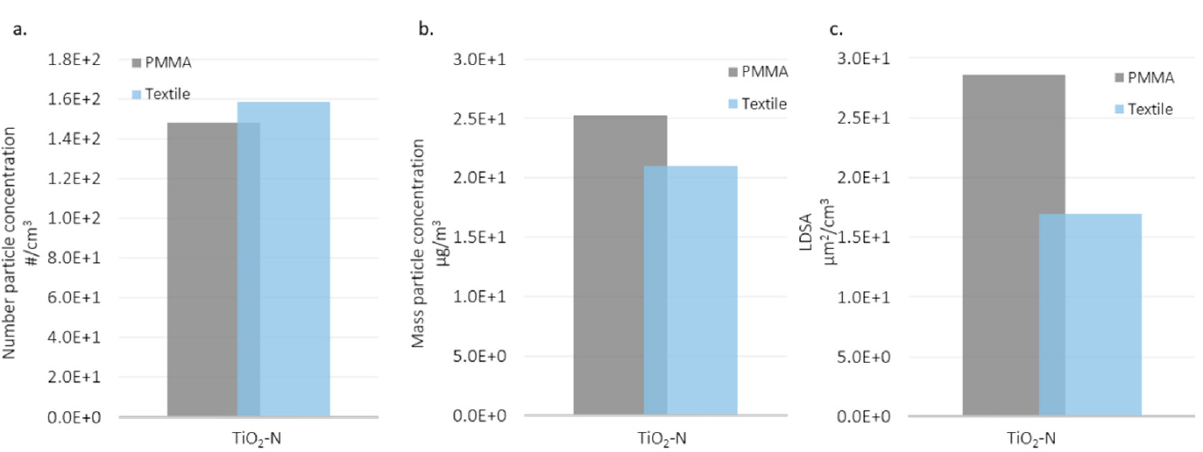
( c ) LDSA values in the particle size range 0.03–0.4 µm. TiO 2 -N in grey, AgHEC in pink.